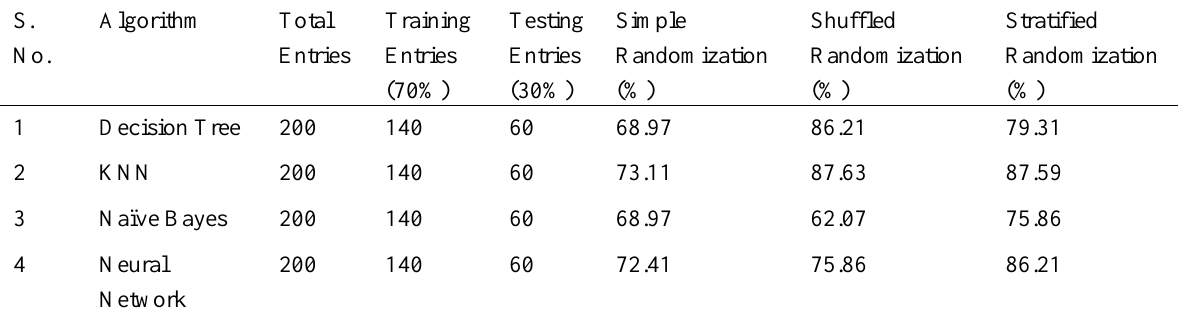
Comparison of the machine learning algorithms applied for actual crowd behaviour S.